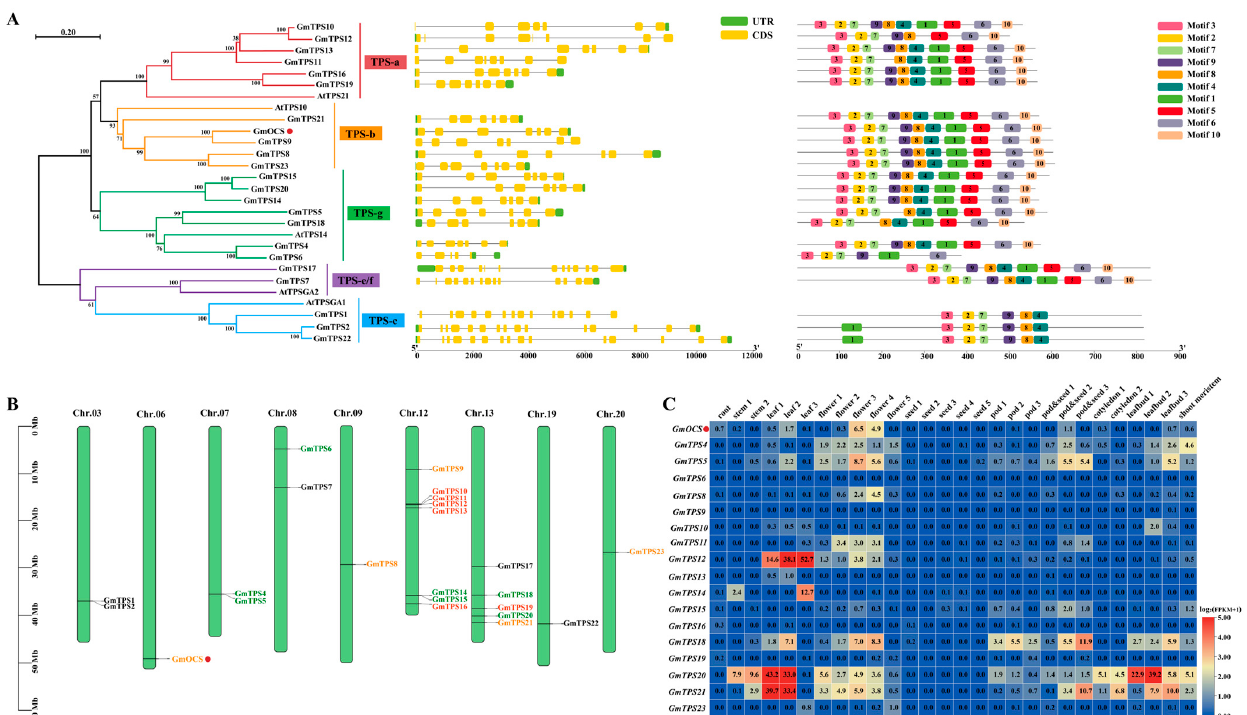
Figure 1. Phylogeny, gene structure, conservative motif, gene location, and expression patterns of GmTPS genes . ( A ) Phylogeny (left panel), gene structure (middle panel), and conservative motif (right panel) analysis of GmTPS sequences. The TPS sequences were processed by Clustal Omega and subjected to MEGA-X to construct the neighbor-joining tree. GmTPS3 was renamed GmOCS later. Bootstrap values were 1000 replicates. Gene structures and conservative motifs were drawn using TBtools [43]. ( B ) Chromosomal distributions of GmTPSs . Different subcladed GmTPSs were characterized in different colors. ( C ) Transcripts of GmTPSs in different tissues or organs of soybean. The data were calculated with earlier published RNA-seq data [42]. The FPKM values were normalized by log 2 and illustrated by TBtools with HeatMap Illustrator